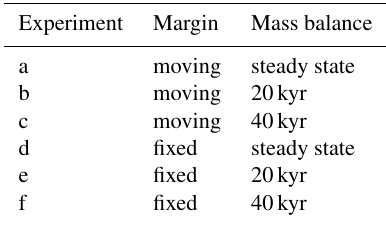
Table 5. The six different EISMINT-I